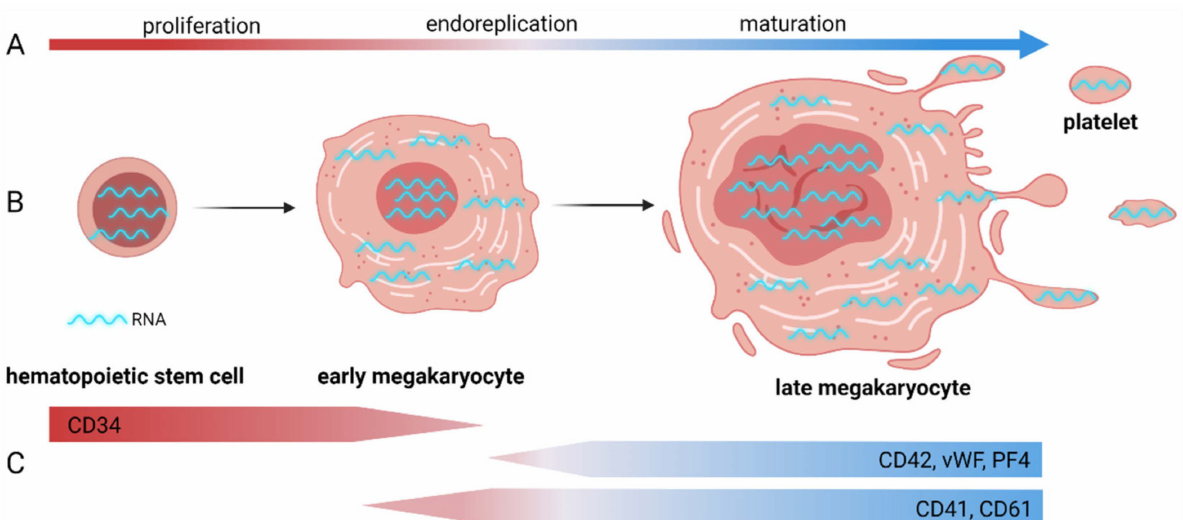
Figure 1. ( A ) Stages in megakaryopoiesis and thrombopoiesis; ( B ) RNA metabolism in maturing megakaryocytes and transfer to platelets during thrombopoiesis; ( C ) different cell markers associated with stages in MK and platelet differentiation (adapted from Davizon-Castillo et al.